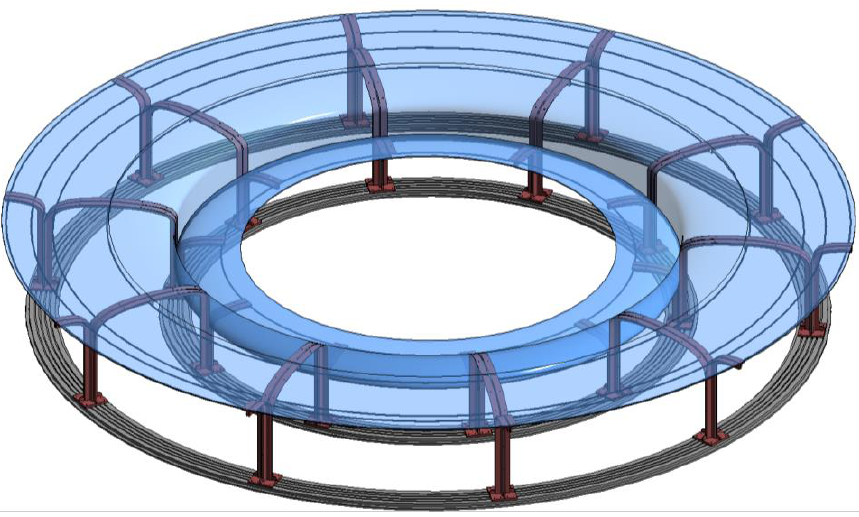
Figure 19. Spatial form of a transverse centripetal building.